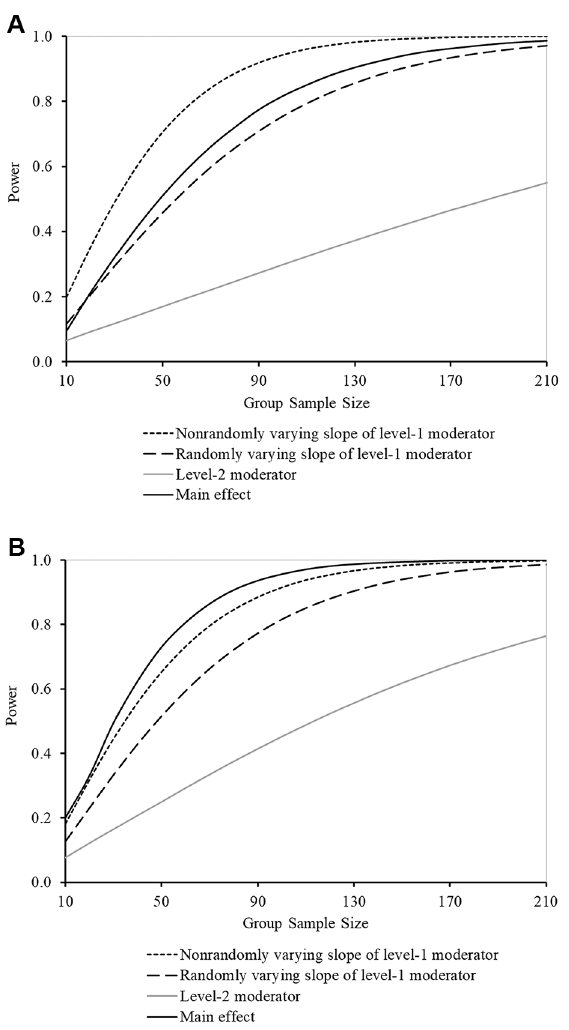
Figure 2 Power vs. Group Sample